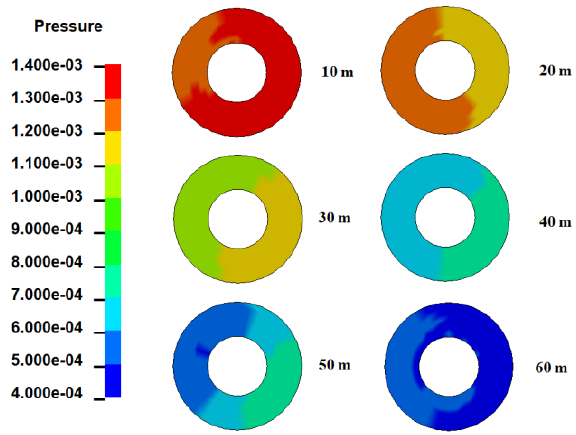
Figure 7. Perforation pressure distribution at different positions of the wellbore (unit: 10 11 Pa).